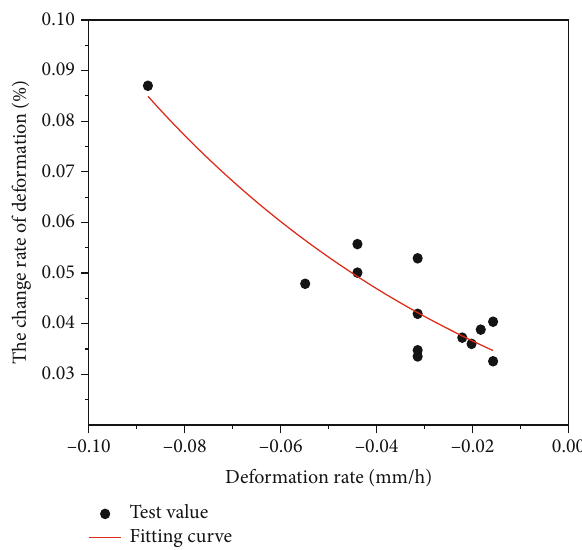
Figure 20: Relation between the change rate of deformation and deformation rate of HC.